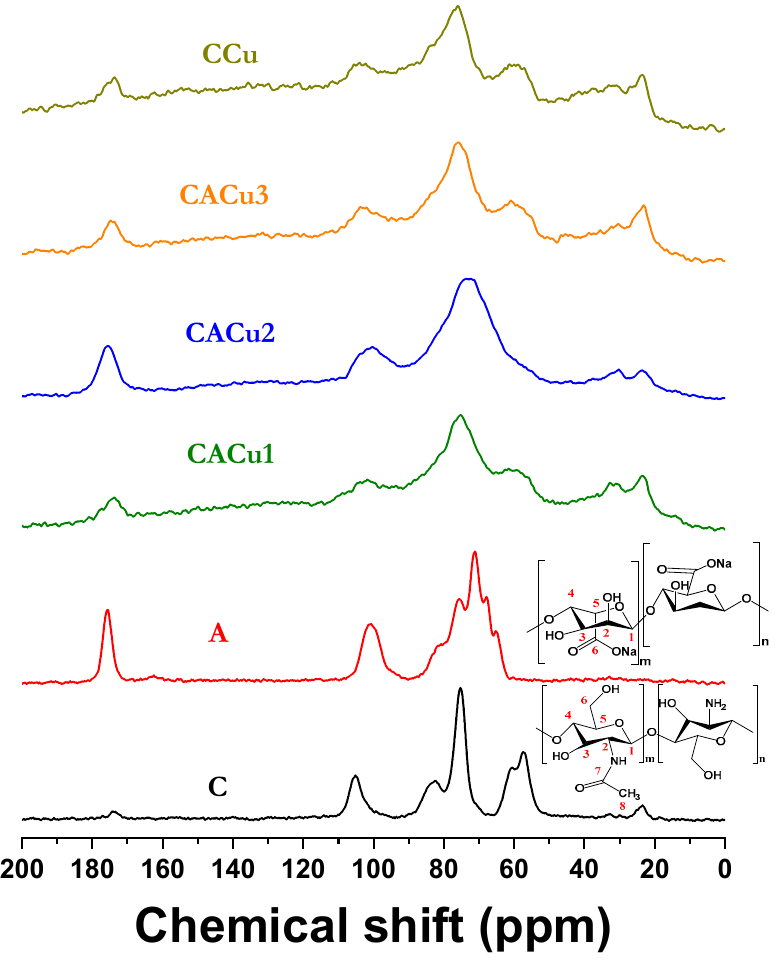
Figure 4. Solid state C-13 NMR of the biopolymers (C, A), binary (CCu) and ternary (CACu1, CACu2, CACu3) composites.